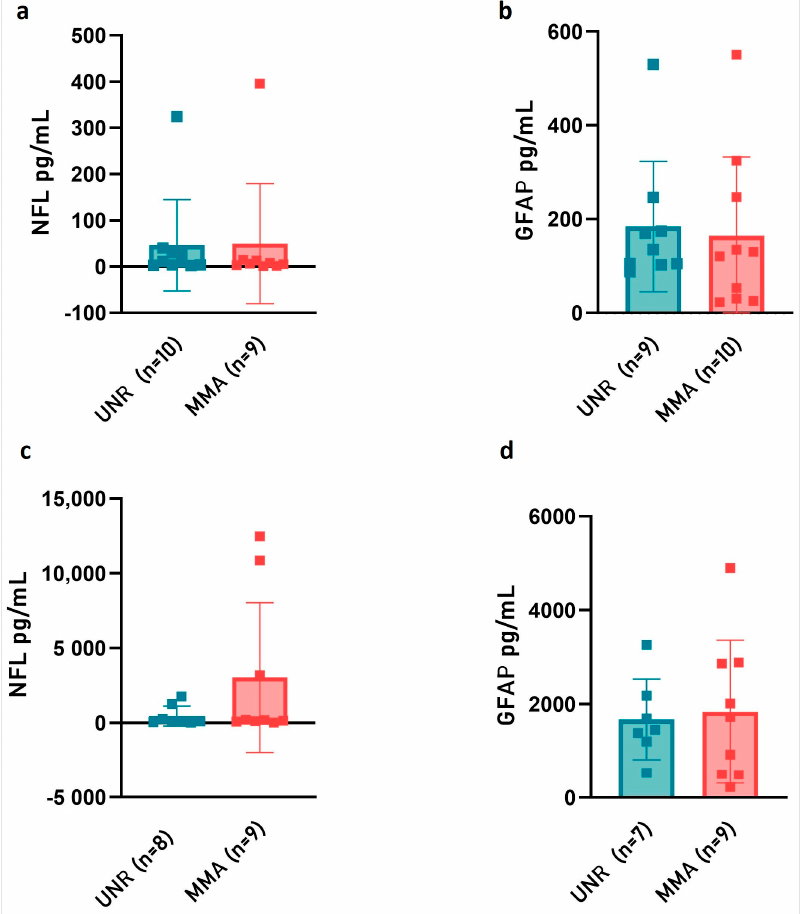
Figure 4. Plasma and CSF concentrations of structural protein factors. The plasma ( a , b ) and CSF ( c , d ) levels of neurofilament light (NfL) and glial fibrillary acidic protein (GFAP) proteins were determined with SiMoA in MMA patients and UNR subjects. Error bars represent mean ± SD. The statistical significance was calculated through Student’s t -test. The values of at least three independent experiments are shown.